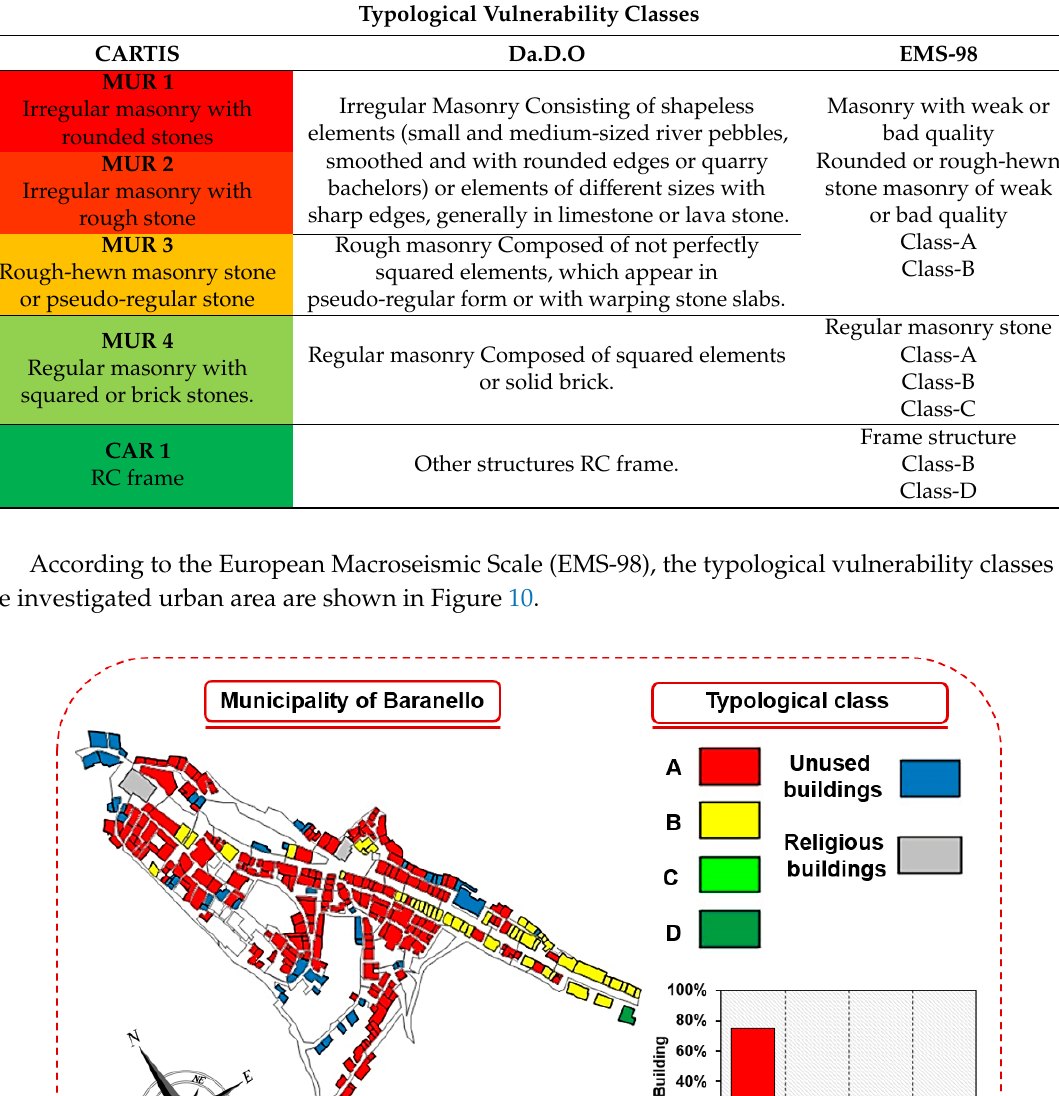
Table 1. Correlation of vulnerability classes among the CARTIS, Da.D.O and EMS-98 methods.